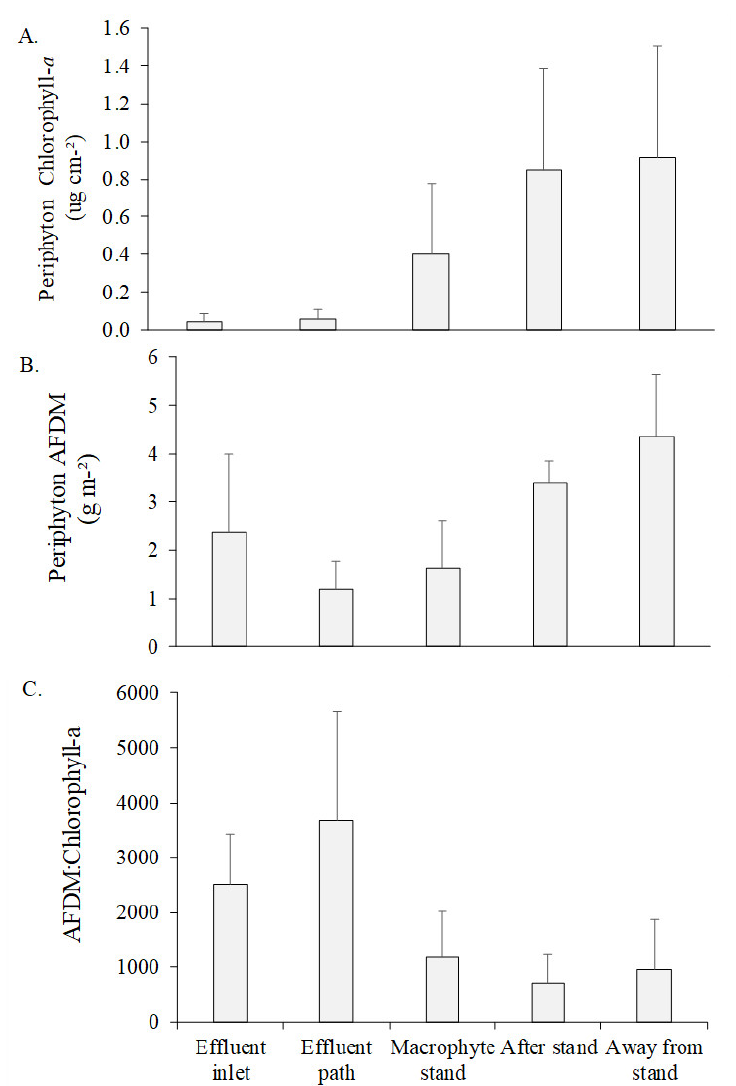
Figure 4. Periphyton chlorophyll- a , ash free dry mass (AFDM) and AFDM:Chlorophyll ratio (mean; SD; n = 3) in the sampling